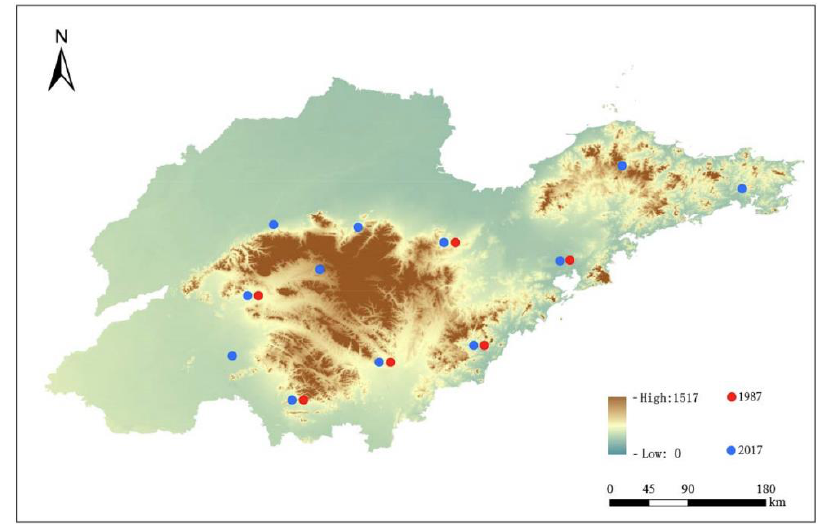
Figure A1. Topographic features of the study area.